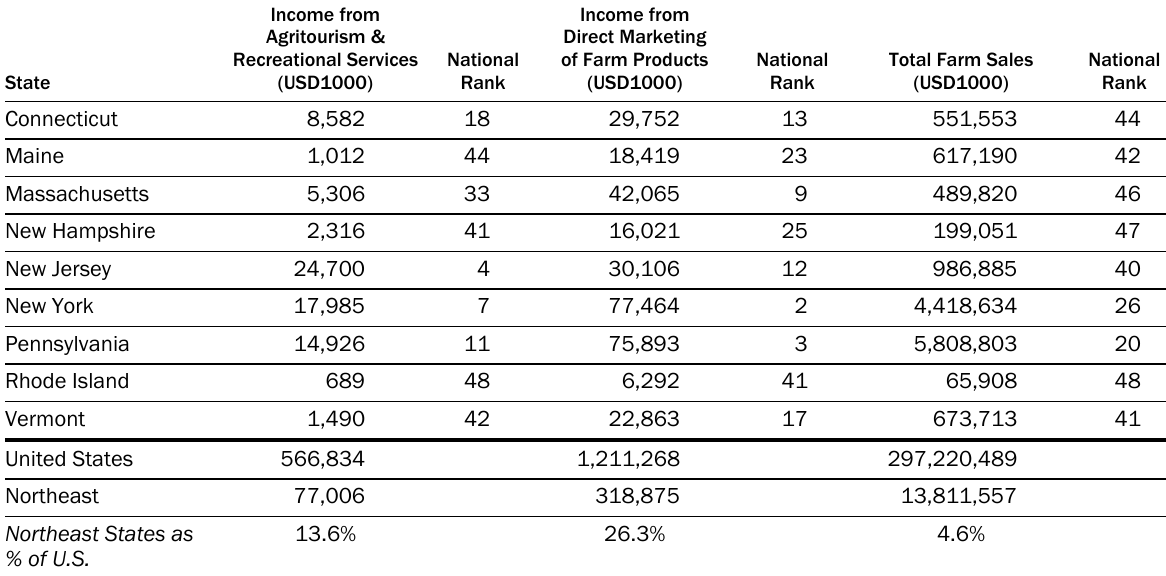
Table 1. Agritourism and Direct Marketing Income in the Northeast: Ranks Among Coterminous States (2007)